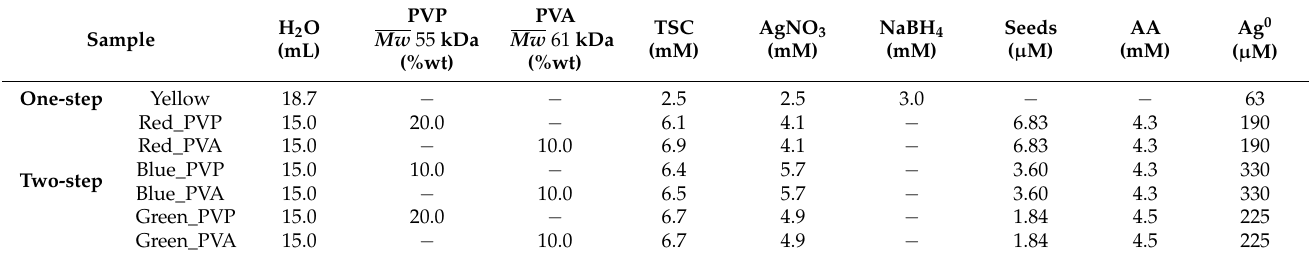
Table 1. Final concentrations of reagents used for the synthesis of concentrated colors. For yellow sol: T = 2 ◦ C and reaction time = 2 h, under dark conditions. For red, blue and green colors, the adopted yellow seeds concentration is 63 µ M; T = 50 ◦ C, reaction time = 10 min, under dark conditions. PVP = polyvinylpyrrolidone; PVA = polyvinyl alcohol; TSC = trisodium citrate; AA = ascorbic